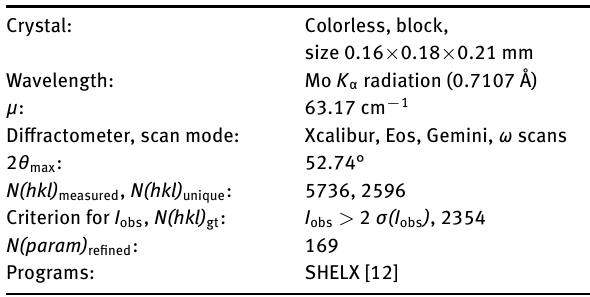
Table 2: Fractional atomic coordinates and isotropic or equivalent isotropic displacement parameters (Å 2